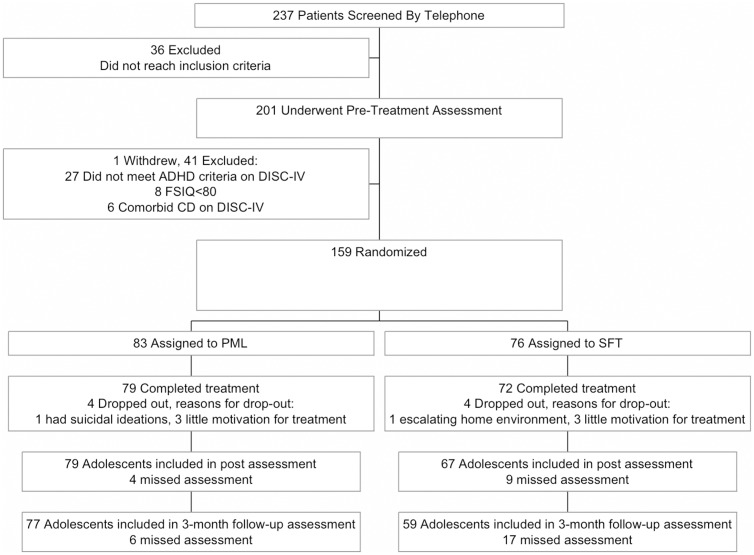
CONSORT flowchart.